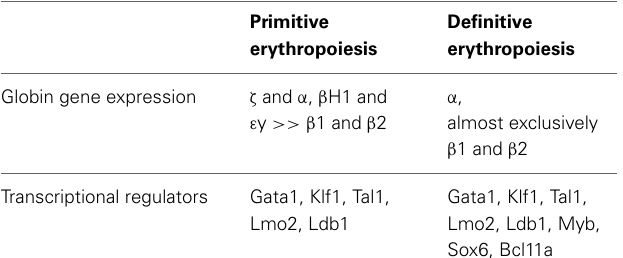
Table 1 | Expression of globin genes and transcriptional regulators in primitive and definitive murine erythroid